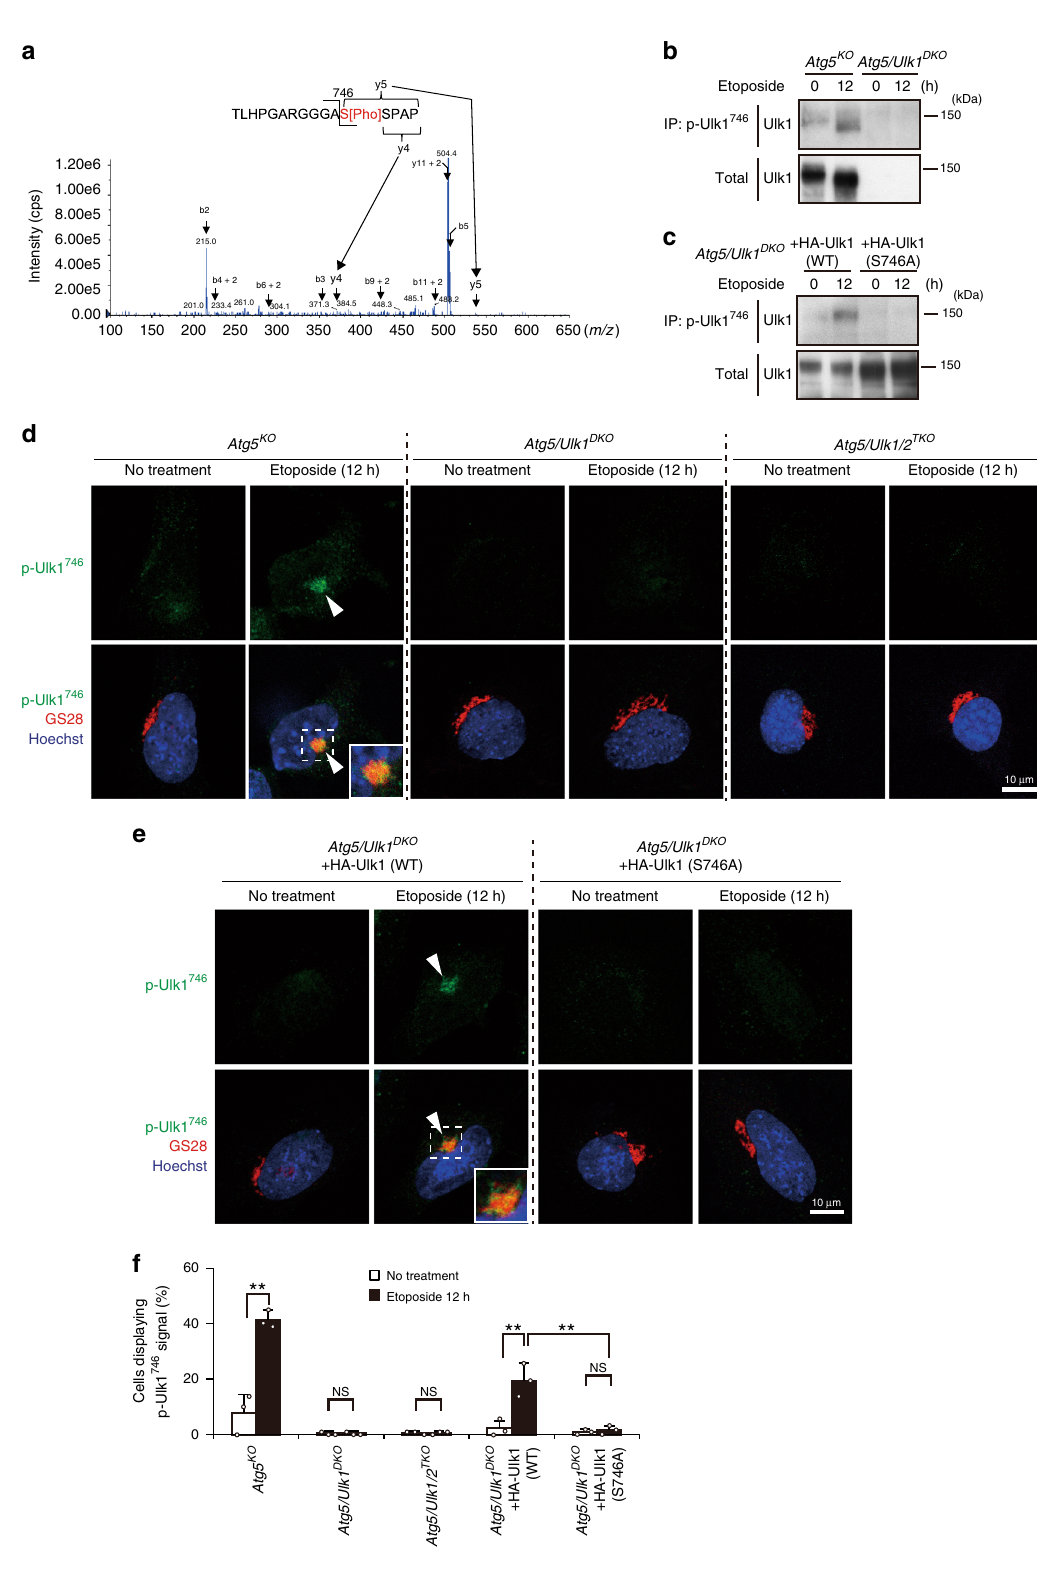
but not HA-Ulk1 (S746A) mutant-expressing Atg5 / Ulk1 DKO MEFs showed p-Ulk1 746 signals after etoposide treatment (Fig. 1e, f). These fi ndings validate the usefulness of our antibody for immuno fl uorescence experiments, and again con fi rmed the etoposide-induced phosphorylation of Ulk1 at Ser 746 . Interestingly, p-Ulk1 746 signals merged almost completely